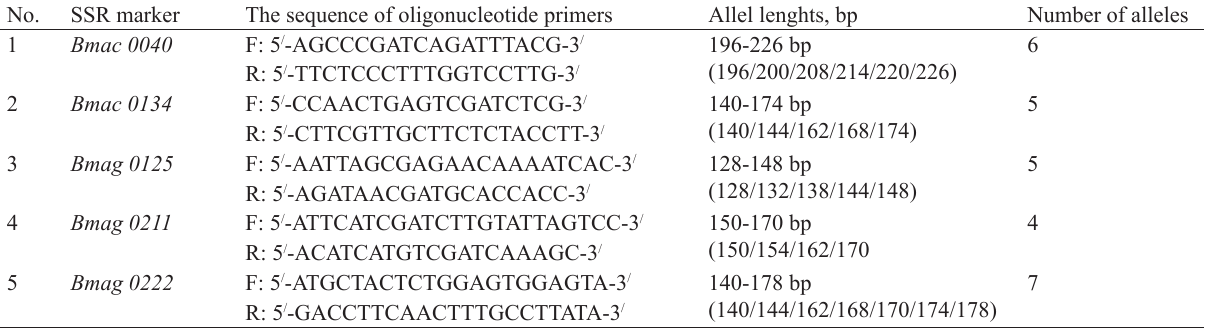
Table 3 SSR-markers of nuclear DNA Hordeum vulgare used for genetic identification of brewing barley varieties, potentially suitable for beer DNA